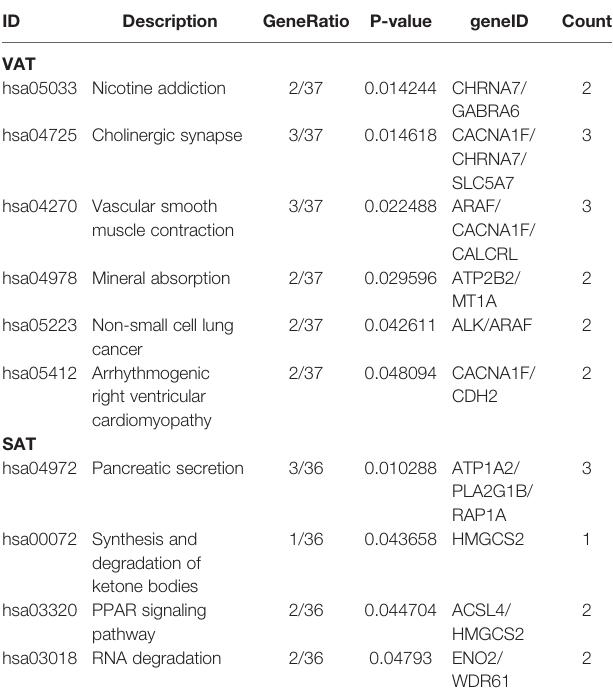
TABLE 1 | KEGG enrichments of target mRNAs in miRNA-mRNA networks of obesity in VAT and